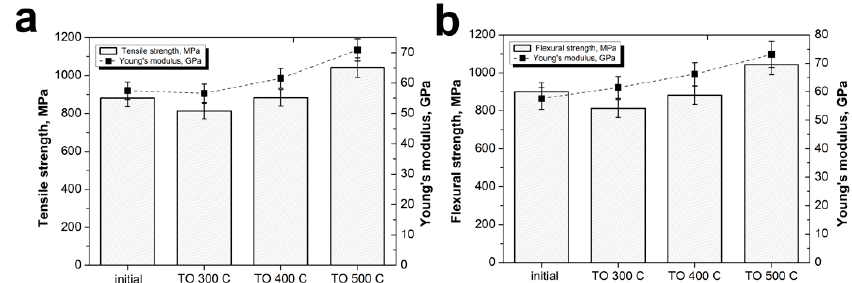
Figure 11. ( a ) Tensile and ( b ) flexural properties of the CF / PSU composites (60 / 40 wt %) reinforced with fiber after various surface modifications.